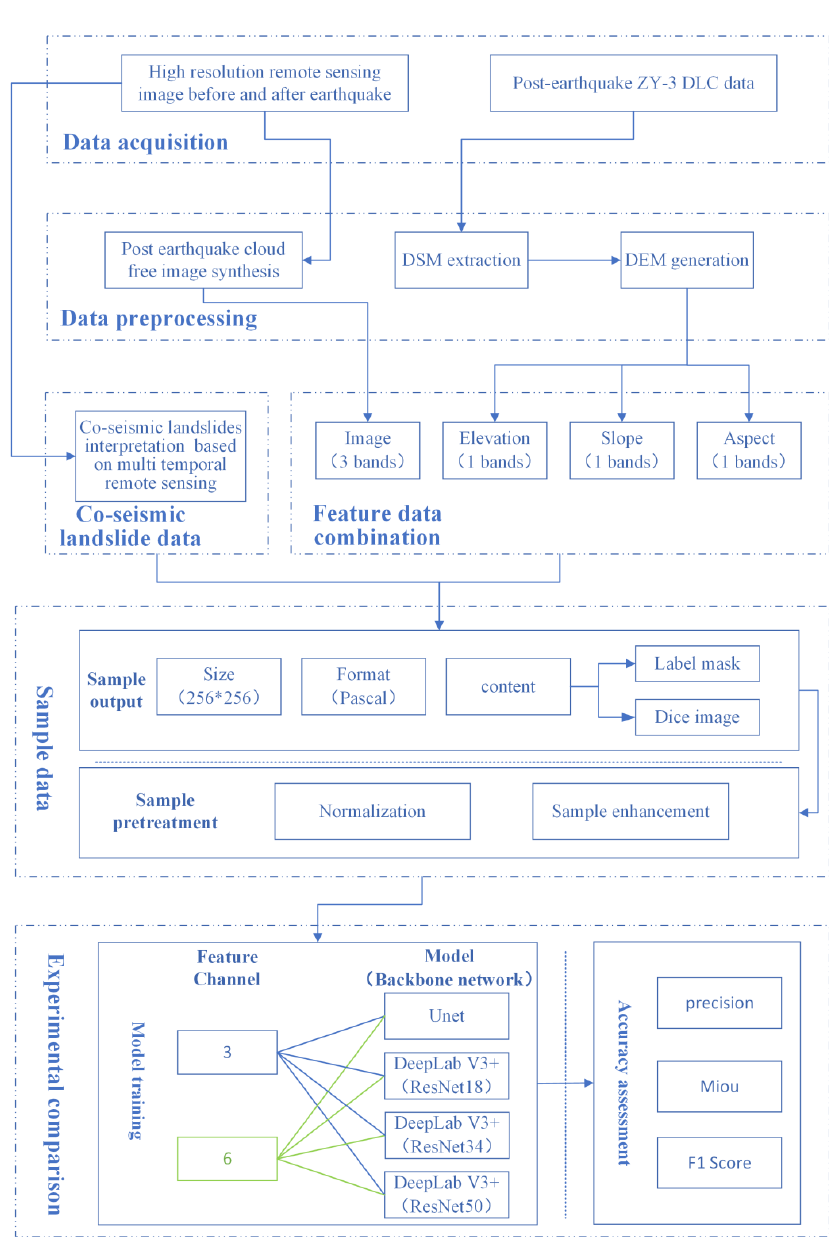
Figure 2. Research